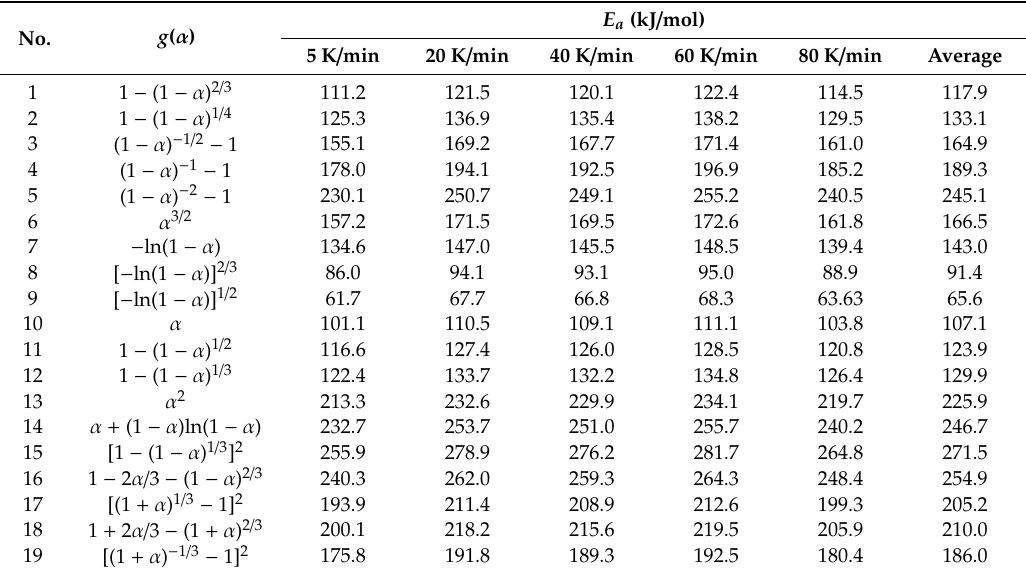
Table 3. Calculation values of E a for the CR